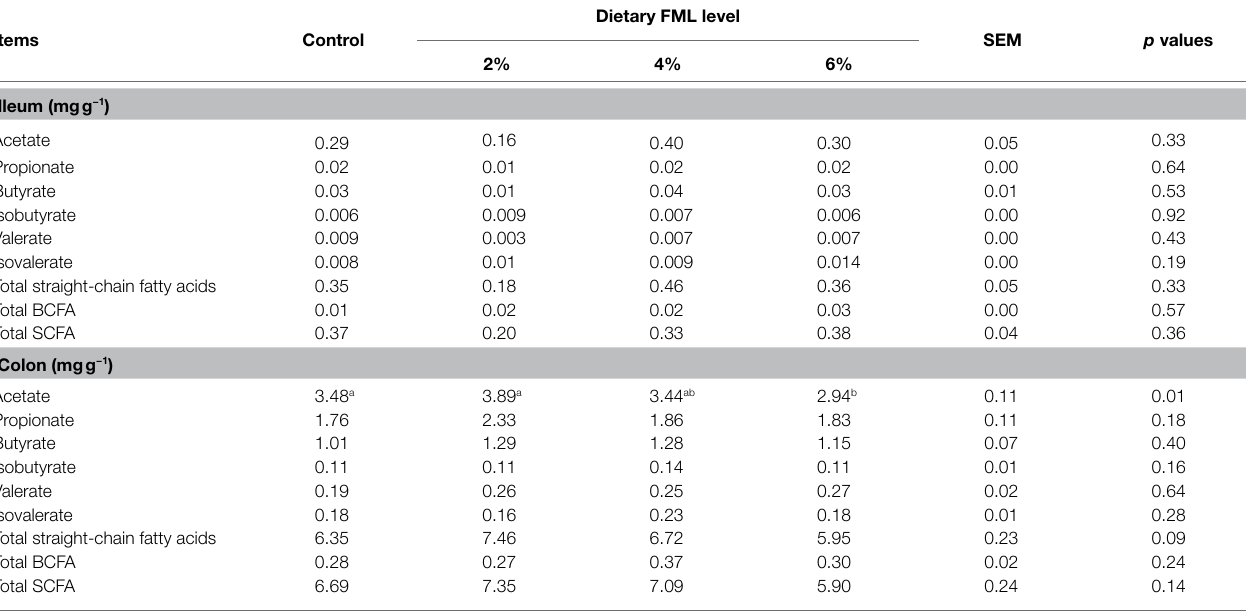
TABLE 5 | Effect of dietary supplementation with fermented Mao-tai less (FML) on intestinal SCFA contents of weaned piglets.